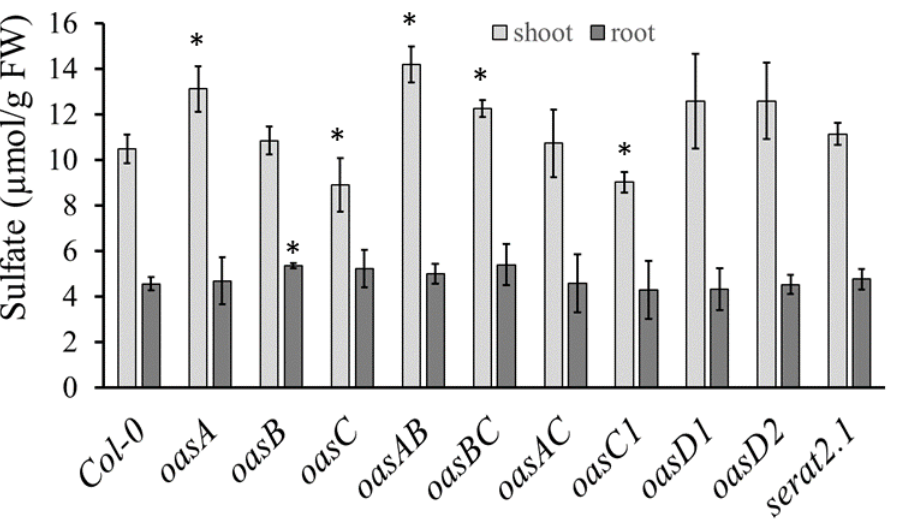
Figure 4. Sulfate accumulation is affected by the mutation of genes for OAS-TL isoforms. Col-0, oasA, oasB, oasC, oasAB, oasAC, oasBC, oasC1, oasD1, oasD2 , and serat2.1 mutant plants were grown on MS-agarose plates for 2.5 weeks. The sulfate concentration of root and shoot was determined. Data are presented as means ± S.D. from four biological replicates. Asterisks mark values signifi- cantly different from the wild-type Col-0 at p < 0.05 (Student’s t -test).